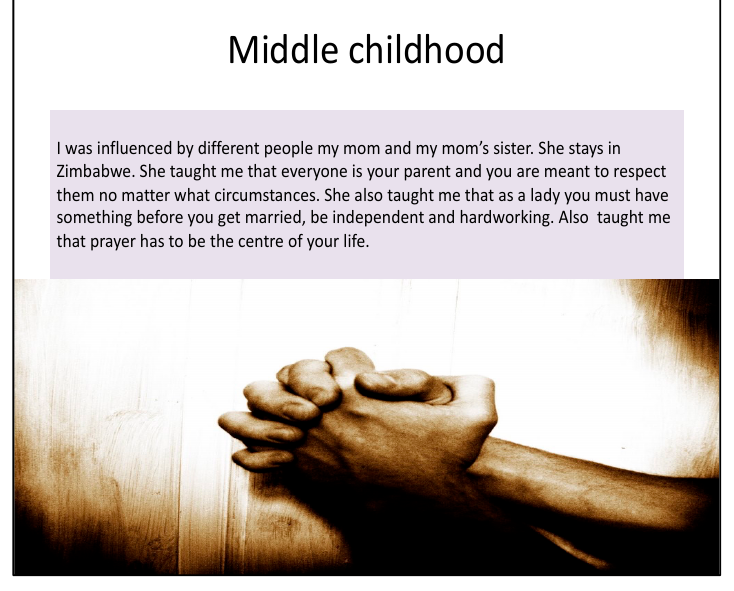
Figure 6. Tanaka’s middle childhood.